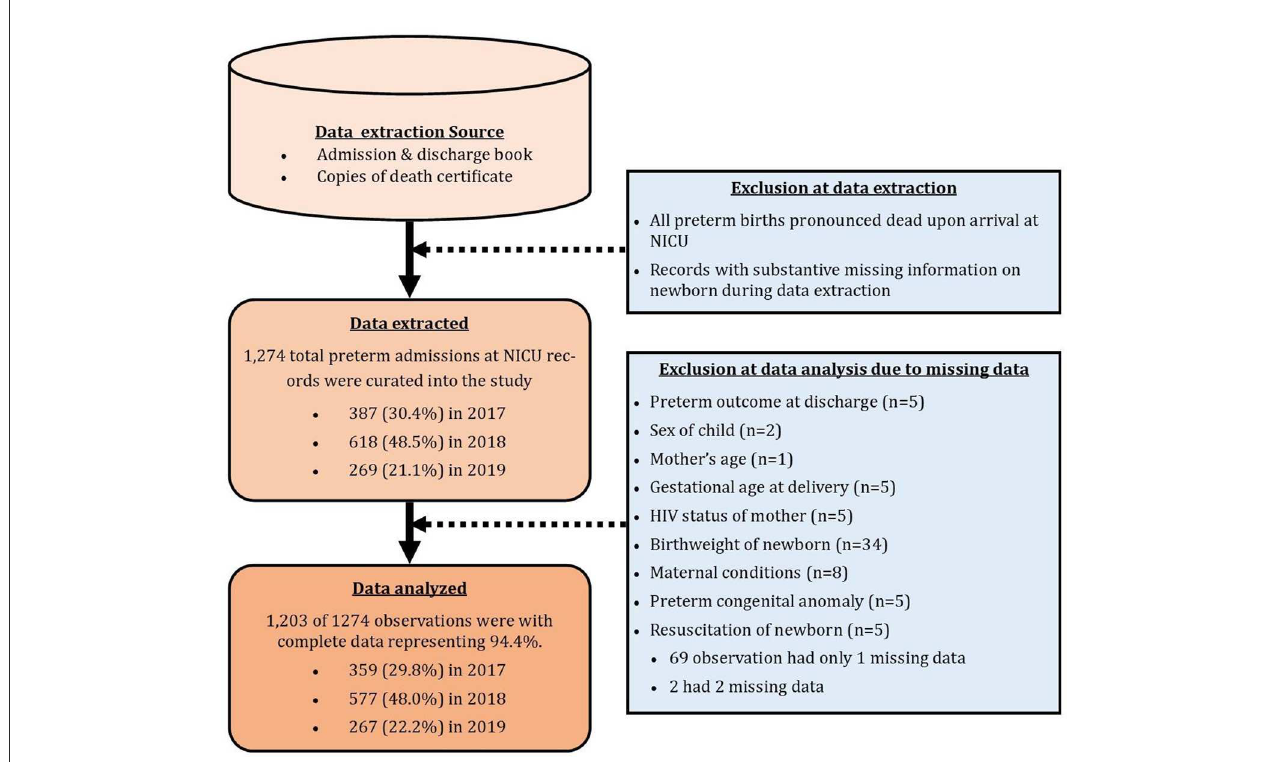
FIGURE1 Flow chart of data extraction, showing missingness and final data used for